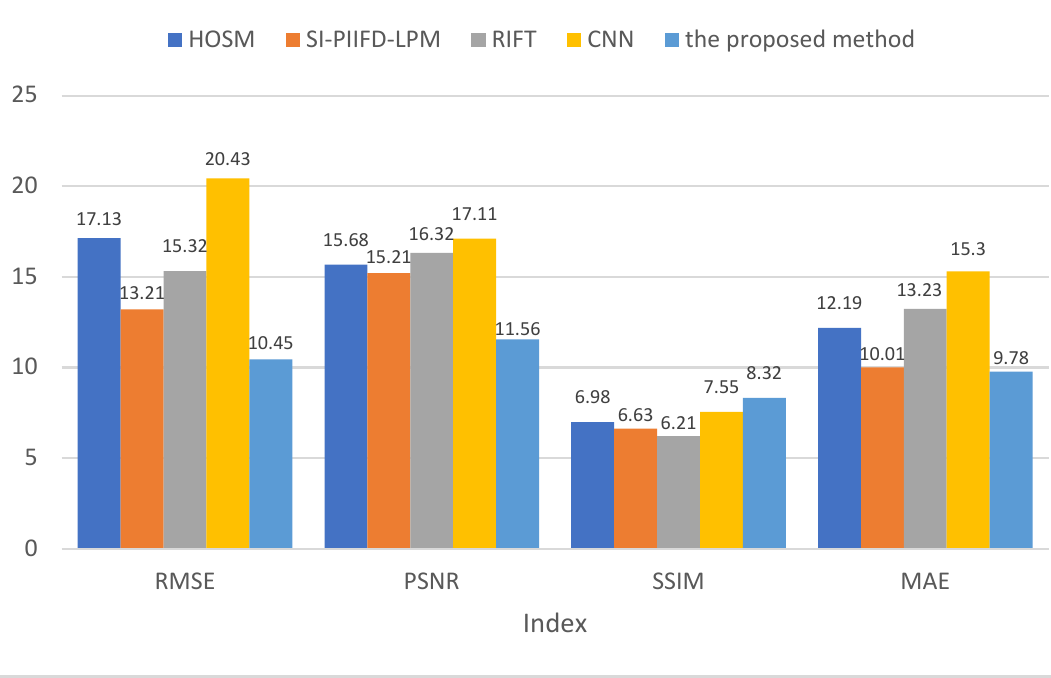
Figure 13. Quantitative evaluation index results of several algorithms.